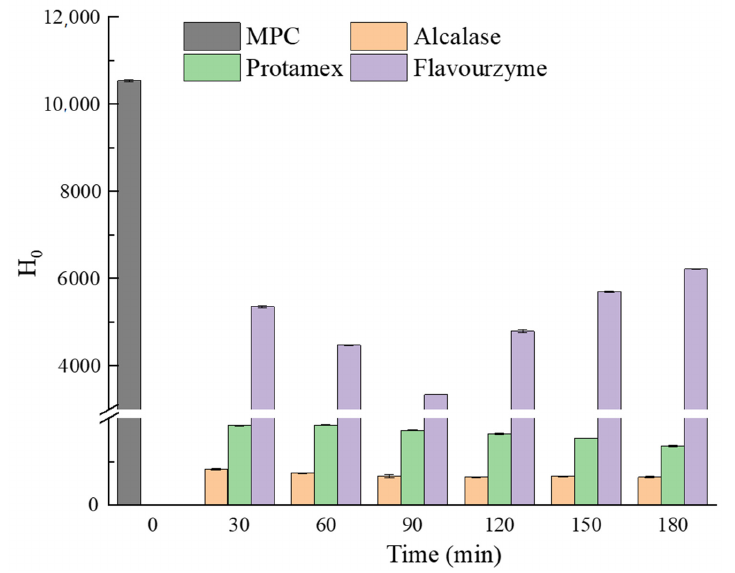
Figure 2. The surface hydrophobicity of control MPC and samples hydrolyzed by Flavorzyme, Alcalase, and Protamex at 30, 60, 90, 120, 150, and 180 min, respectively. Table 2. Particle size of MPC hydrolysates by Alcalase, Flavorzyme, and Protamex. Particle Size Sample (min)